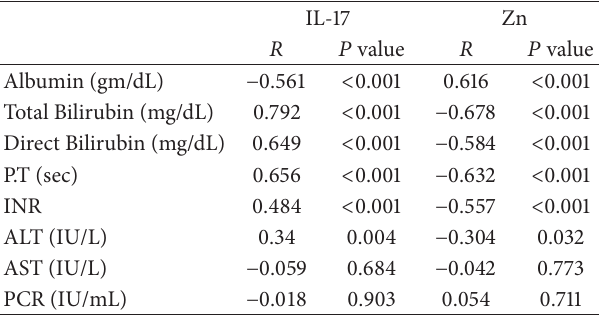
Table 2: Correlations between IL17 and Zn and different parameters in hepatitis C virus infected